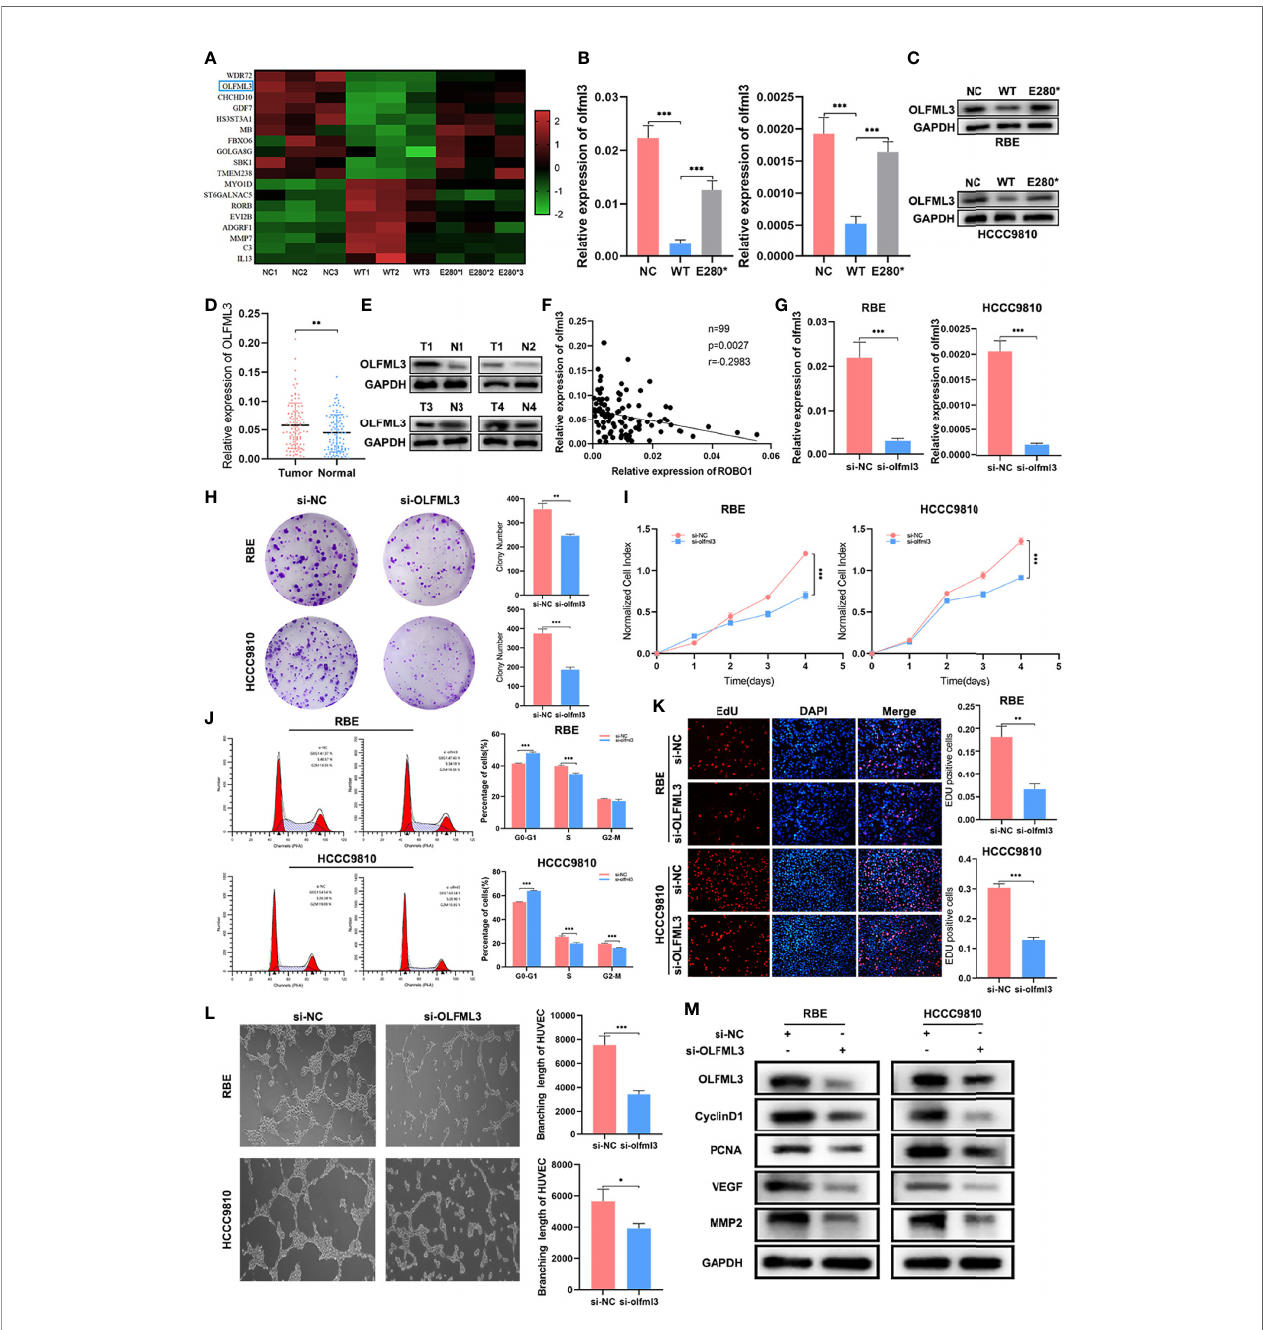
FIGURE 6 | OLFML3 was a potential target regulated by ROBO1 WT and ROBO1 E280 *. (A) Heat map of differentially expressed genes that have a reverse expression trend in the ROBO1 E280 * group compared with the ROBO1 WT group. (B, C) Veri fi cation of OLFML3 expression in RBE and HCCC9810 cell line by RT-qPCR and western blotting analyses. OLFML3 expression was downregulated by ROBO1 WT and recovered by ROBO1 E280 *. (D) The RT-qPCR analysis of OLFML3 expression showed an upregulated trend in cholangiocarcinoma (CCA) tissues. (E) Western blotting analysis of typical OLFML3 expression in CCA and normal tissues. (F) Scatter diagram illustrating the negative correlation between ROBO1 and OLFML3 mRNA expression. (G) Knockdown of OLFML3 in RBE and HCCC9810 cell line. (H) The knockdown of OLFML3 signi fi cantly impaired the clone formation ability of RBE and HCCC9810 cells. (I) The knockdown of OLFML3 signi fi cantly reduced the proliferation rate of RBE and HCCC9810 cells. (J) Flow cytometry analysis of the cell cycle of RBE and HCCC9810 cells transfected with si-OLFML3 and si-NC. (K) The EdU-positive RBE and HCCC9810 cells were decreased by the knockdown of OLFML3. (L) The human umbilical vein endothelial cell line branching length was signi fi cantly decreased by the knockdown of OLFML3 in RBE and HCCC9810 cells. (M) Western blotting analysis showed a lower expression of cyclin D1, PCNA, VEGF, and MMP2 in si-OLFML3 cells. * P < 0.05, ** P < 0.01, *** P <